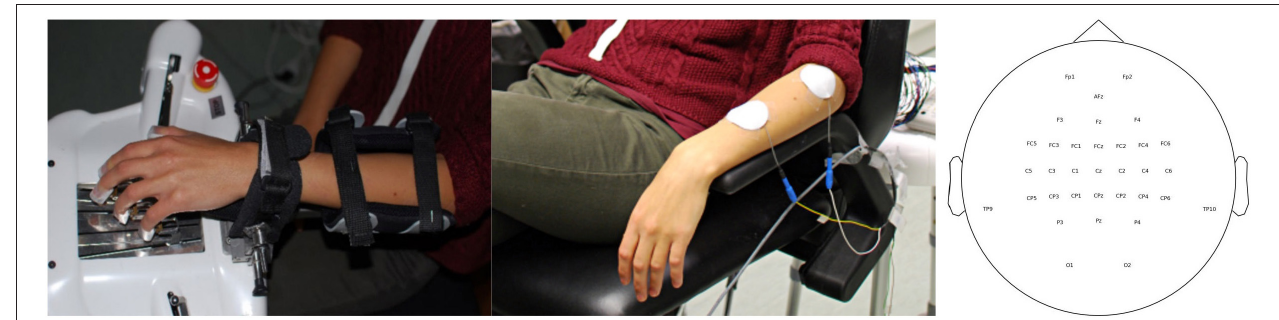
FIGURE 1 | Experimental set-up. (Left) Robotic hand orthosis as feedback device (Amadeo, Tyromotion GmbH, Graz). (Middle) Neuromuscular forearm stimulation as feedback device (RehaMove 2, Hasomed GmbH, Magdeburg). In both cases, a brain-machine interface (BMI) detected motor imagery-related oscillations in the beta frequency band by an electroencephalogram (EEG) and provided via a BCI2000-system contingent feedback by moving the hand with either the robot or the electrical stimulation. (Right) The EEG montage used in this